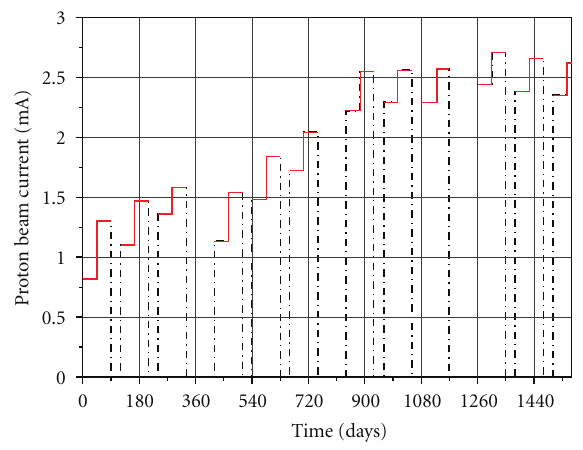
Figure 6: Evolution of proton beam current.